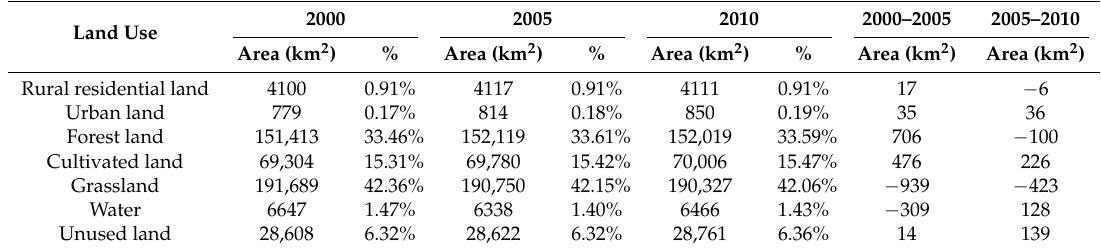
Table 5. Land use change between 2000 and 2010 in the northeastern Inner Mongolia Autonomous Region.